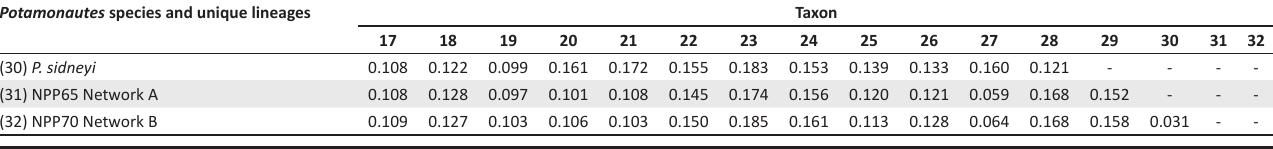
TABLE 1-A1 (Continues...): Sequence divergences among Southern African Potamonautes species and unique lineages found in KwaZulu-Natal. Divergences are uncorrected sequence divergences, calculated from the combined 16S ribosomal DNA and cytochrome c oxidase subunit I mitochondrial DNA sequence